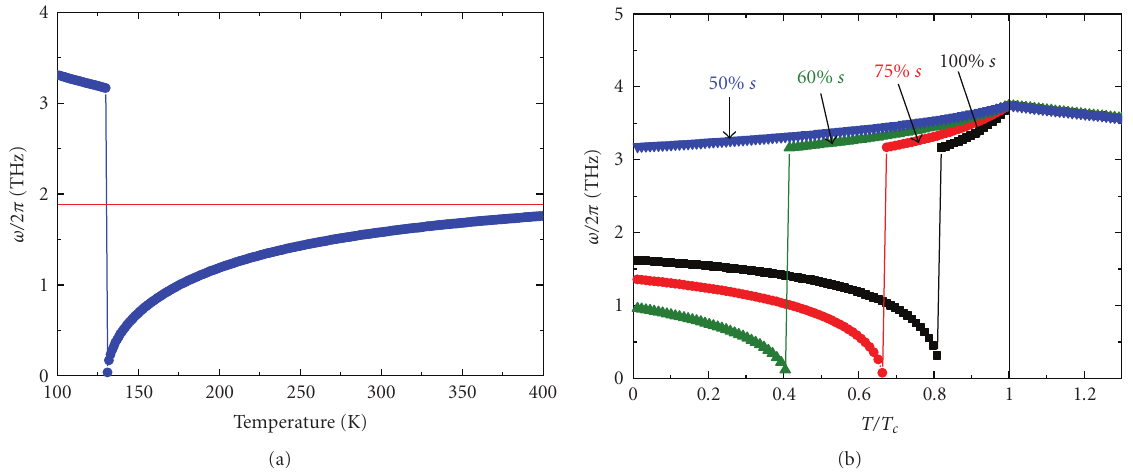
Figure 15: (a) Temperature dependence of the polaronic mode for T > T c . The dashed line indicates the unrenormalized local mode frequency and the deviation from it signals the onset of the polaron formation temperature. (b) Dependence of the polaronic mode on the reduced temperature T/T c . The colour code refers to the s + d wave admixture as indicated in the